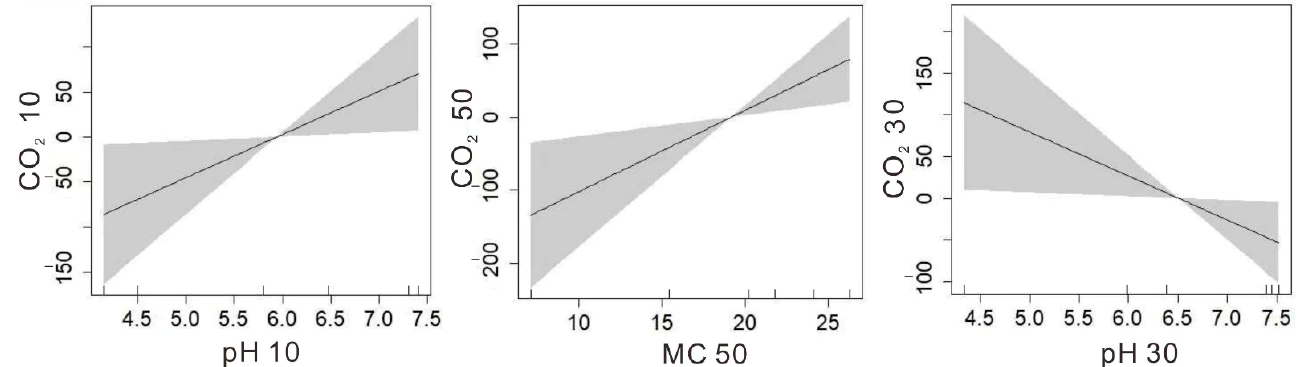
Figure 5. Relationships between gas fluxes and soil properties in NRWNNR. The ( left ) picture shows the relationship between CO 2 fluxes and pH in 10 cm soil layer in VSBP and VSLG, the ( middle ) picture shows the relationship between CO 2 fluxes and MC in 50 cm soil layer in VSBP and VSLG, and the ( right ) picture shows the relationship between CO 2 fluxes and pH in 30 cm soil layer in SBP and SLG.